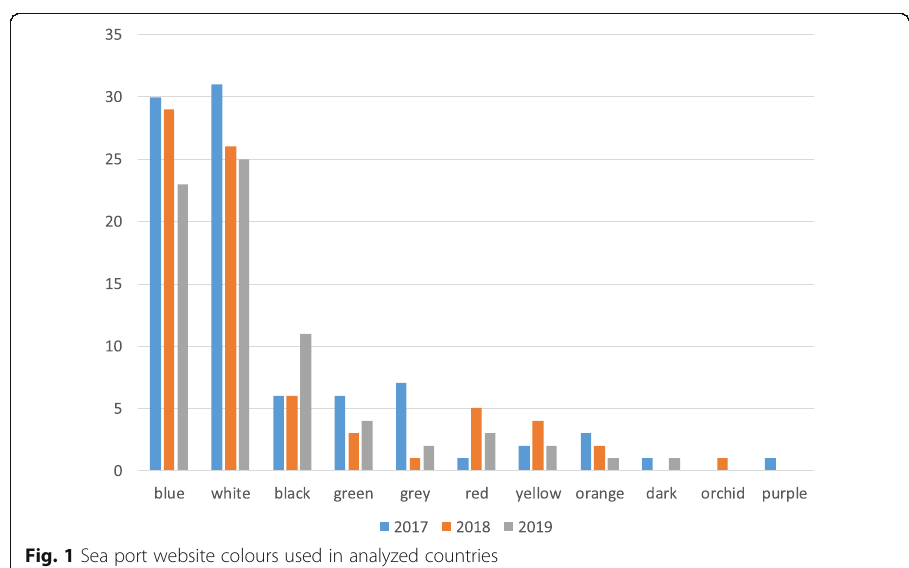
Fig. 1 Sea port website colours used in analyzed countries